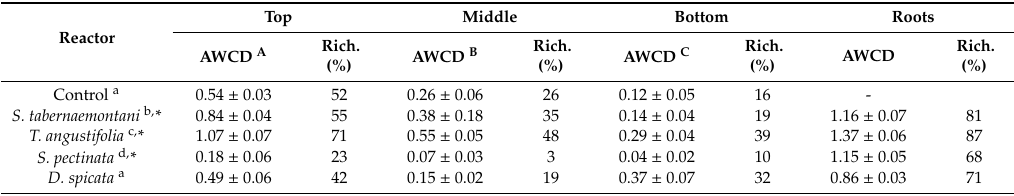
Table 1. Mean average well color development (AWCD) values’ standard deviation and mean total richness (%) in each bioreactor at three depths (wood chips) and plant roots. Note that plant roots were not subject to pair-wise